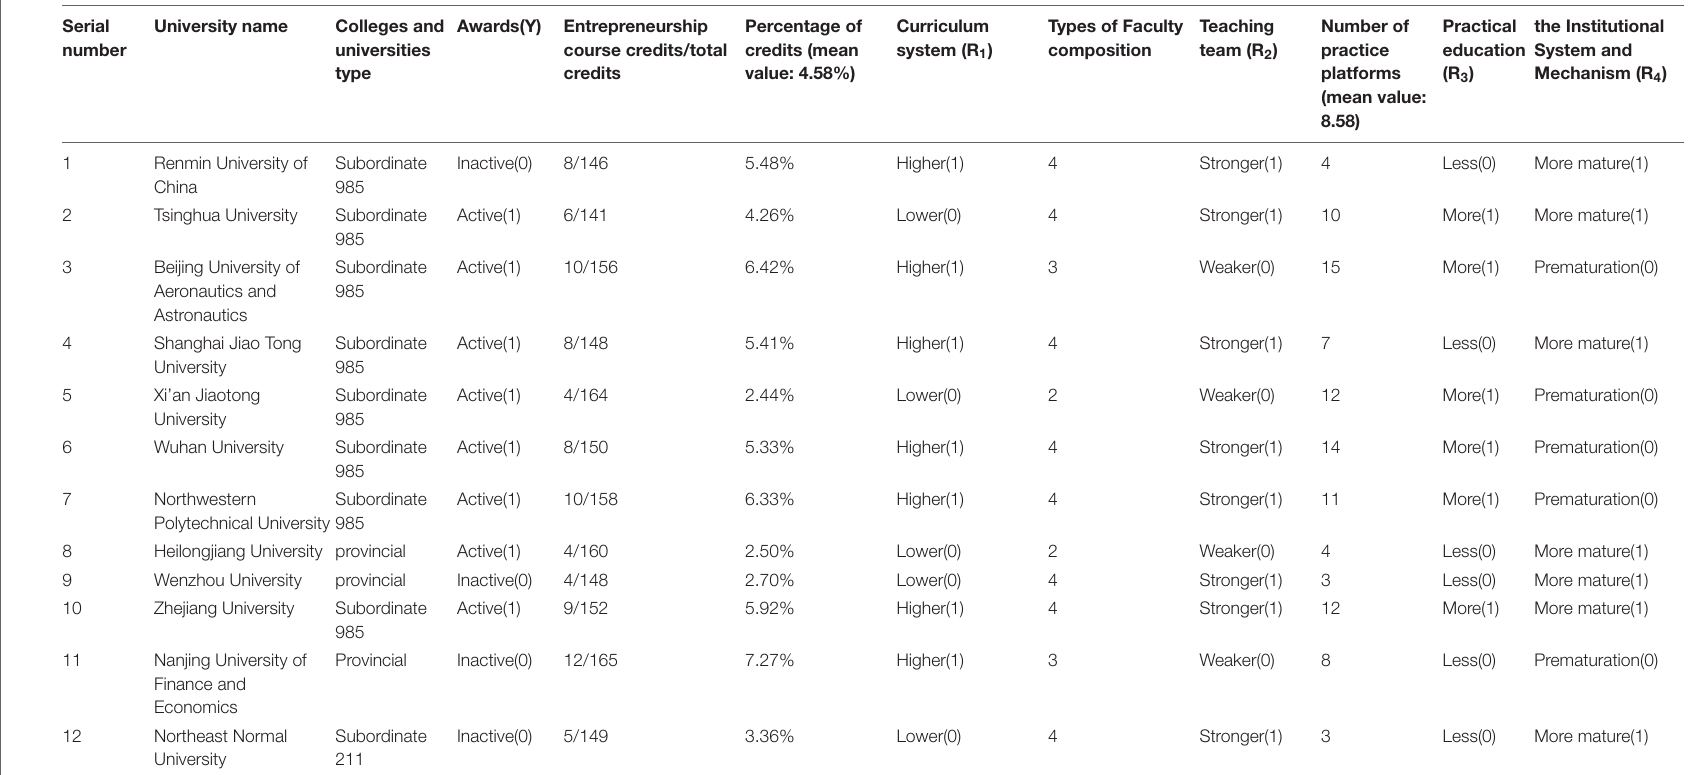
TABLE 1 | Universities’